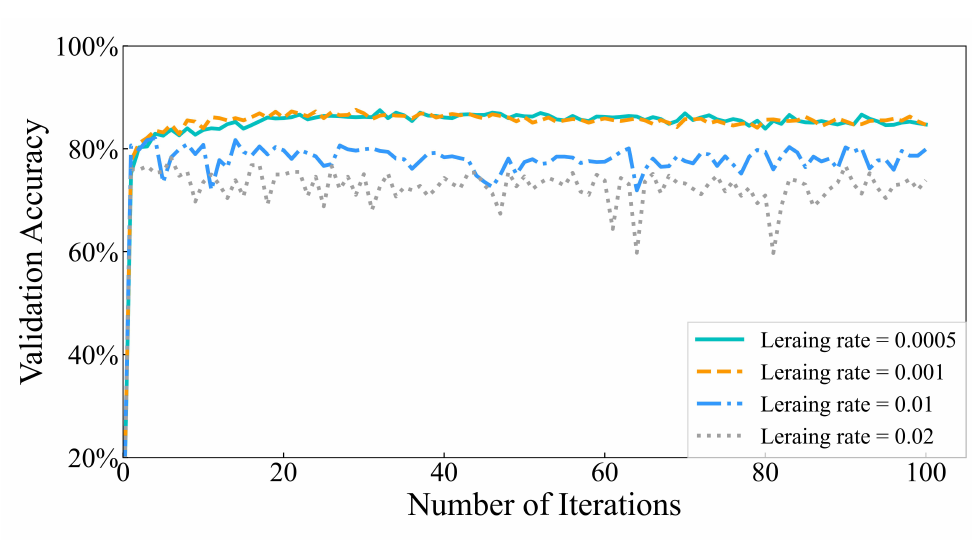
Figure 7. Typical training processes with different learning rates (taking network “2 layers 128 cells” as an